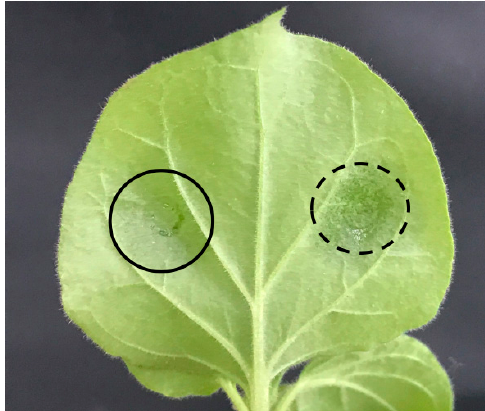
Figure 10. Tobacco leaf image showing the regions infiltrated by the Agrobacterium . The left-half part of the leaf was infiltrated with Agrobacterium containing the RcWRI1 expression vector, while the right-half part of the leaf was infected by Agrobacterium containing an empty vector. The solid black circle shows the region infiltrated by the target gene, and dotted black circle marks the region infected by the empty-vector control.